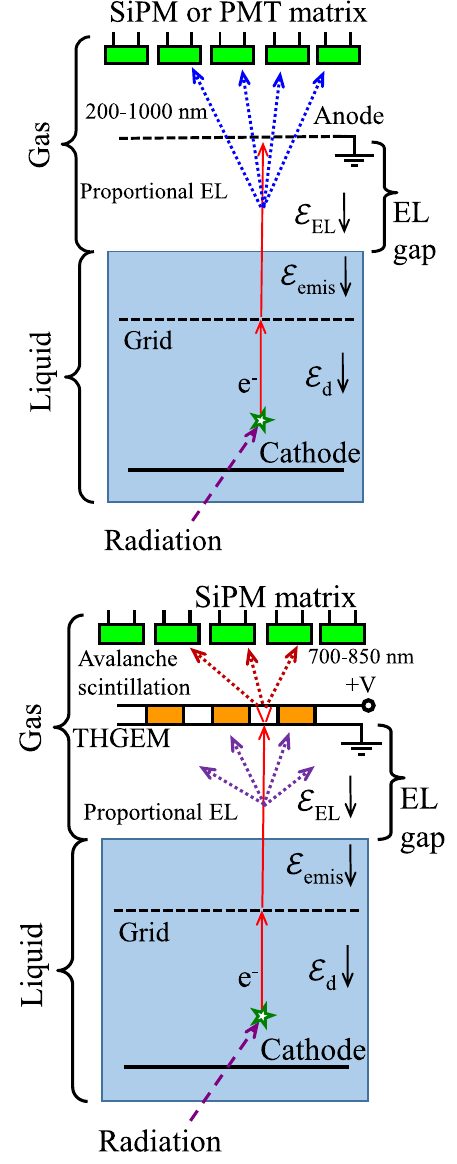
Fig. 4 Two alternative concepts of SiPM-matrix readout of two-phase argon detectors with EL gap proposed elsewhere [14,15] and exper- imentally studied in the present work: that of SiPM matrix directly coupled to EL gap (“direct SiPM-matrix readout”) (top) and that of combined THGEM/SiPM-matrix multiplier coupled to EL gap (“THGEM/SiPM-matrix readout”)